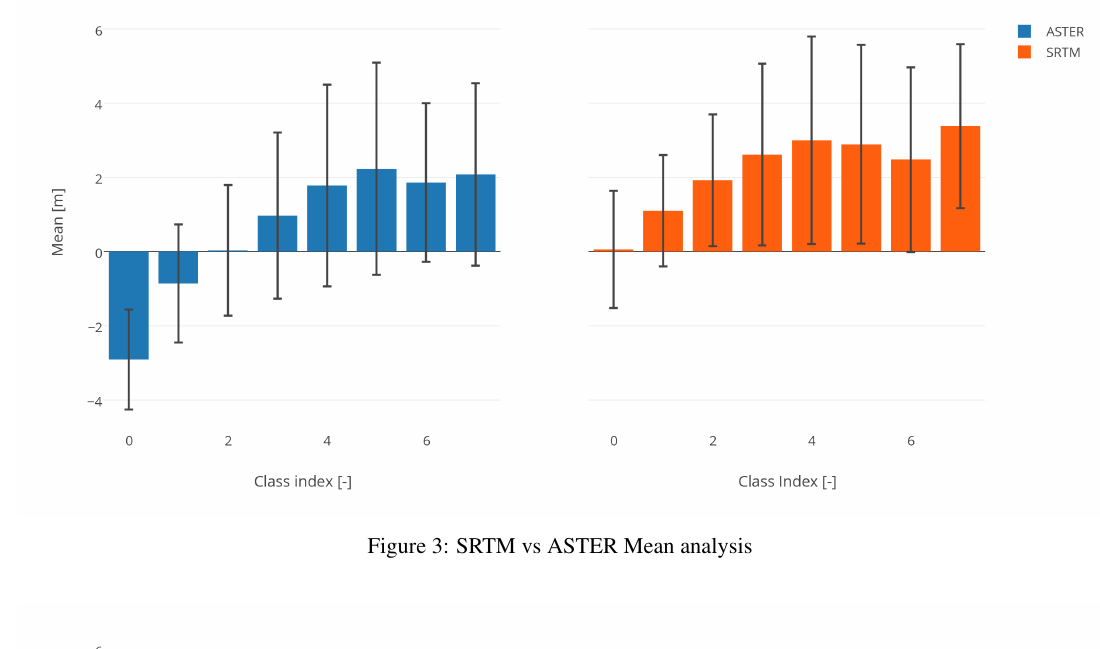
Figure 3: SRTM vs ASTER Mean analysis